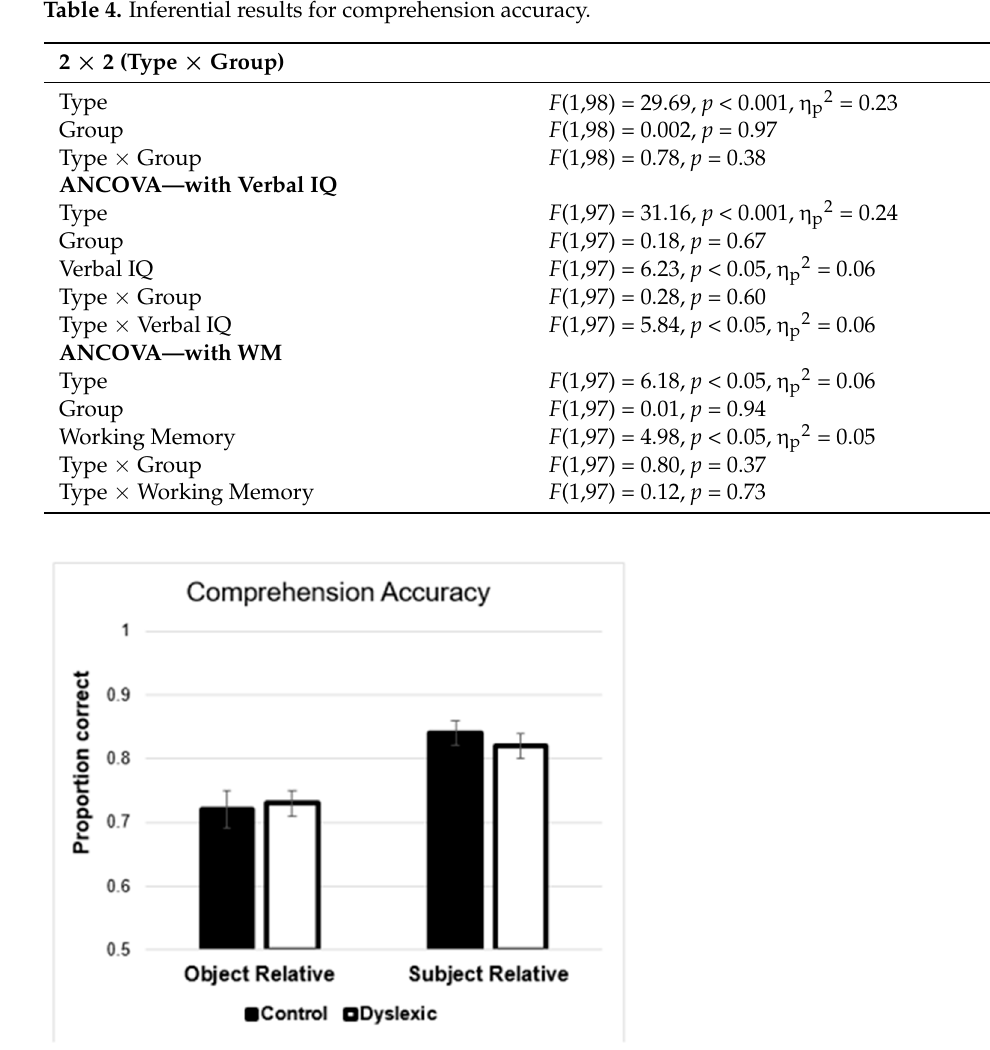
Table 5. Mean reading times clause by group and experimental condition - relative verb.